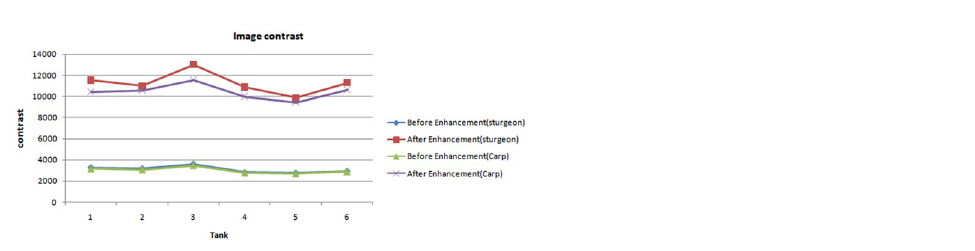
Figure 8. Image contrast of the two